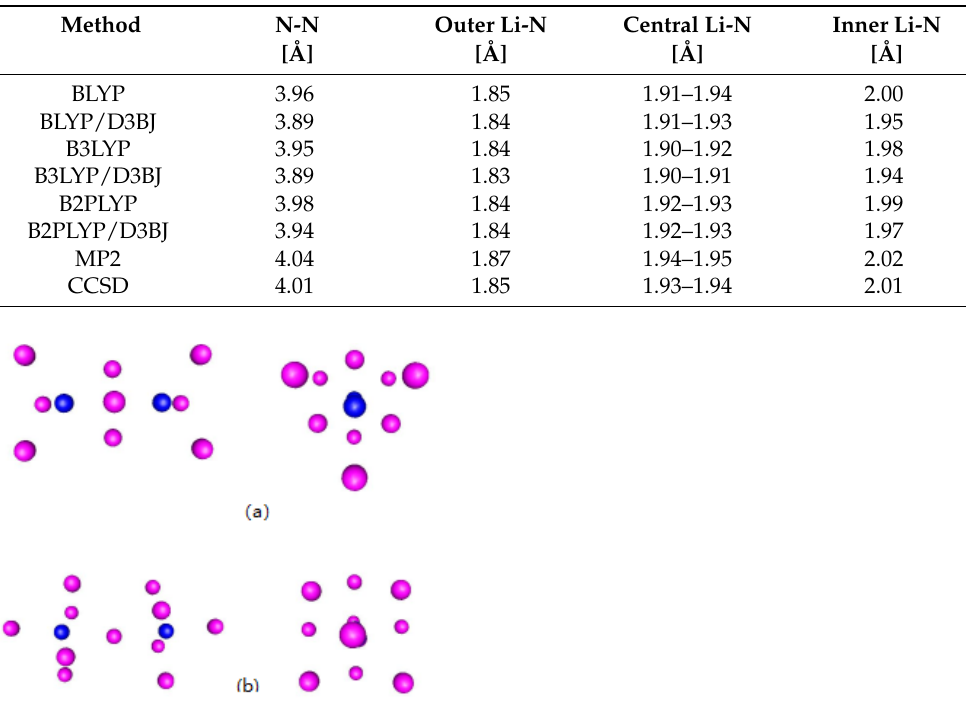
Table 3. Optimized Li 11 N 2 structure, method comparison. Each nitrogen atom is coordinated by six lithium atoms. The two nitrogen atoms share one lithium atom.